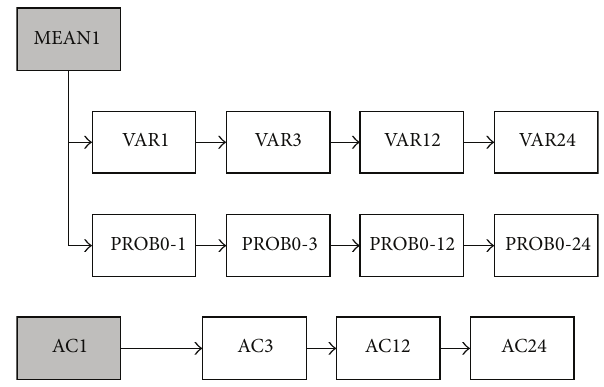
Figure 5: The sequence of a short-term rainfall statistics generation.